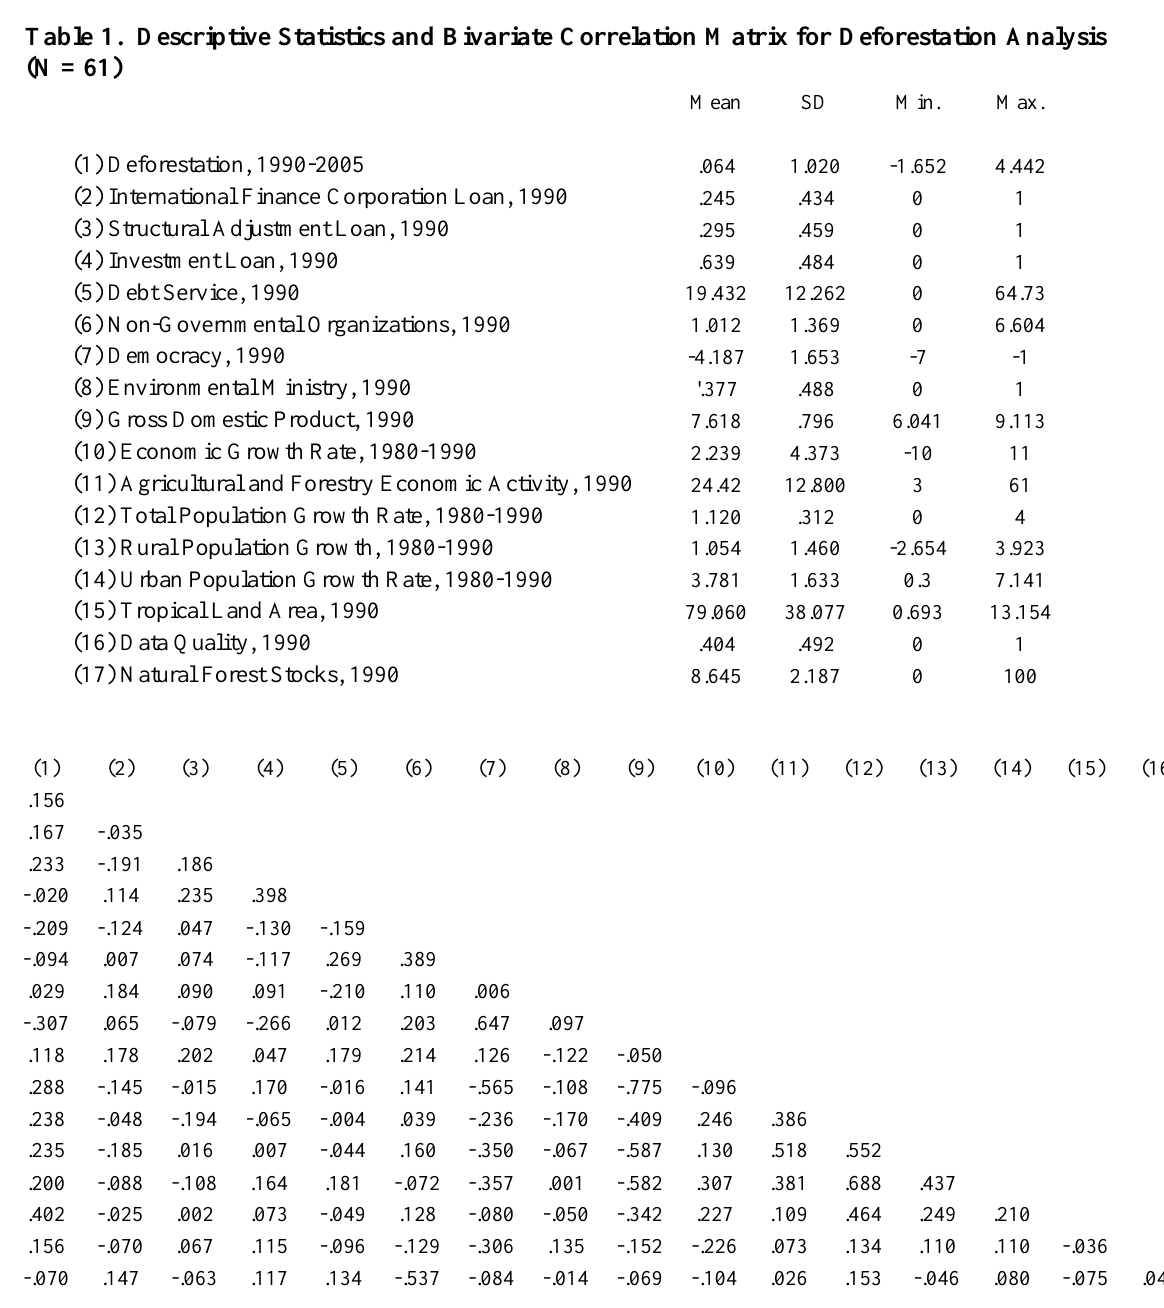
Table 1. Descriptive Statistics and Bivariate Correlation Matrix for Deforestation Analysis (N = 61)